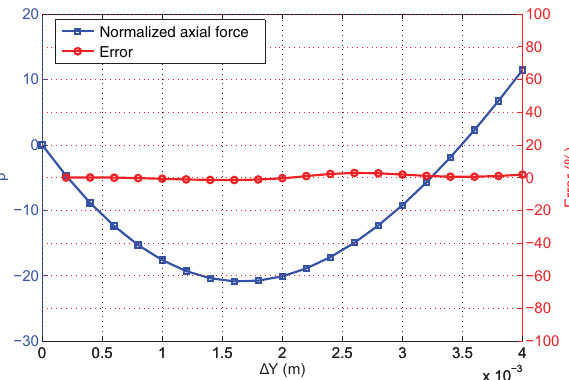
Figure 12. Comparision of normalized axial force and error of Ex- ample